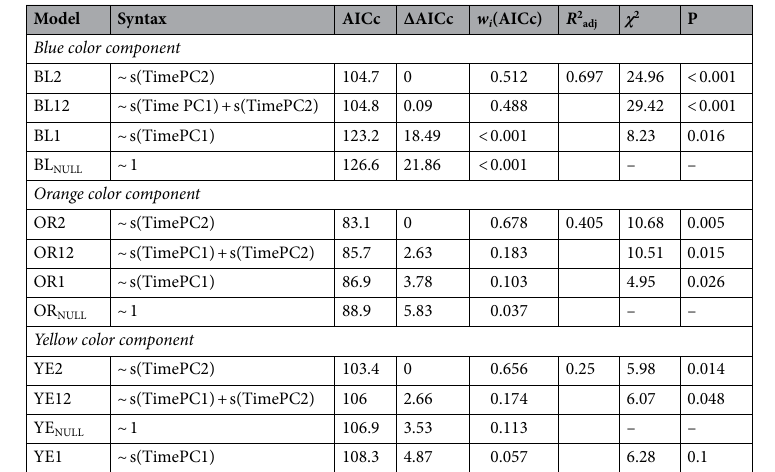
Table 3. Effects of climate on the occurrence of blue, orange, and yellow color components on the throat badge of male lizards in the time-series dataset. A series of candidate generalized additive models were used to evaluate the effect of climate (TimePC1 and TimePC2) on color component frequency. Nagelkerke’s R 2 values (adjusted for low sample sizes) are provided for the best-fit model for each allele (i.e., lowest AICc and highest w i [AICc]). Likelihood-ratio tests compare model fit to a null model. See "Methods" for variable